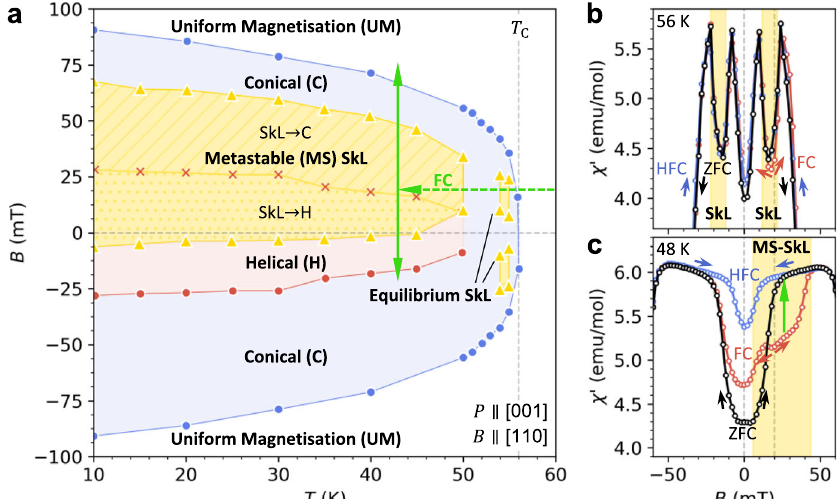
Fig. 2 Metastable skyrmion phase diagram. a The magnetic phase diagram of the (Cu 1 − x Zn x ) 2 OSeO 3 sample, as determined by measurements of the electric polarisation P along the [001] crystallographic axis, when the magnetic fi eld is applied along the [110] axis. The phase diagram was determined by fi eld cooling (FC) at 20 mT, as indicated by the green arrow. The uniform magnetisation (UM, white), conical (C, blue), helical (H, red) and equilibrium skyrmion lattice (SkL, yellow) phases are labelled. The metastable SkL phase is divided into two regions, where it overlays the equilibrium conical (yellow hatched) and helical (yellow dotted) phases. b , c The real component of the AC susceptibility data χ 0 measured after zero fi eld-cooling (ZFC, black), high fi eld-cooling (HFC, blue) and fi eld-cooling (FC, blue). The decrease in χ 0 characteristic of the formation of skyrmions is highlighted by the yellow fi ll. The typical relaxation of χ 0 associated with metastable skyrmion decay is indicated by the green